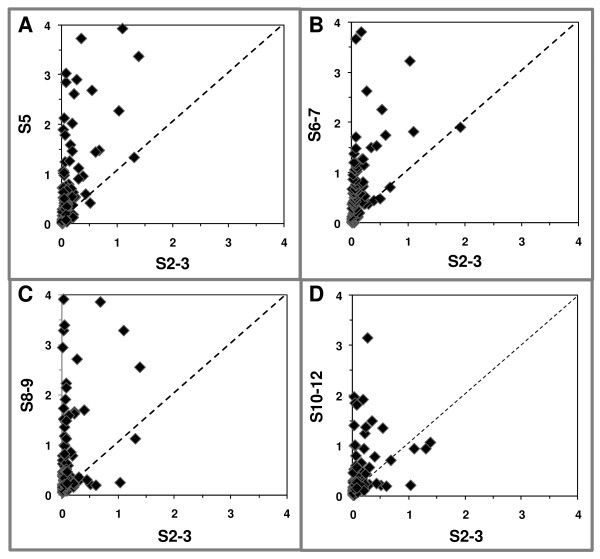
Up-regulation of subtracted transcripts during development. In each graph, the normalized hybridization signal intensities of genes whose expression changed significantly between any developmental interval and the reference interval were plotted on the y axis for stages 5 (S5; A), 6-7 (S6-7; B), 8-9 (S8-9; C) or 10-12 (S10-12; D), and on the x axis for stages 2-3 (S2-3). The diagonal line indicates no change in expression.